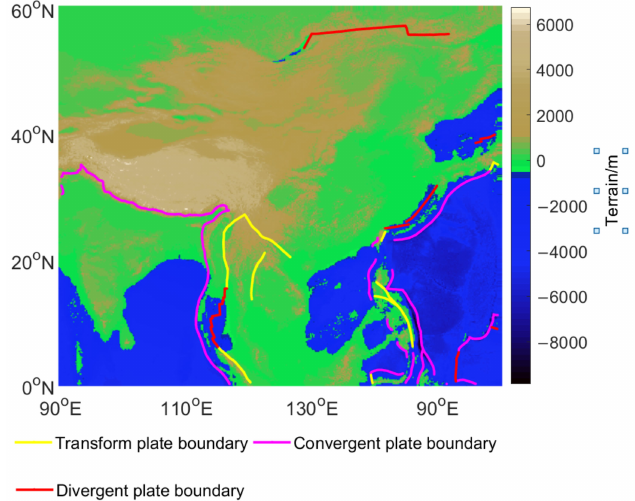
Figure 3. The terrain in the study